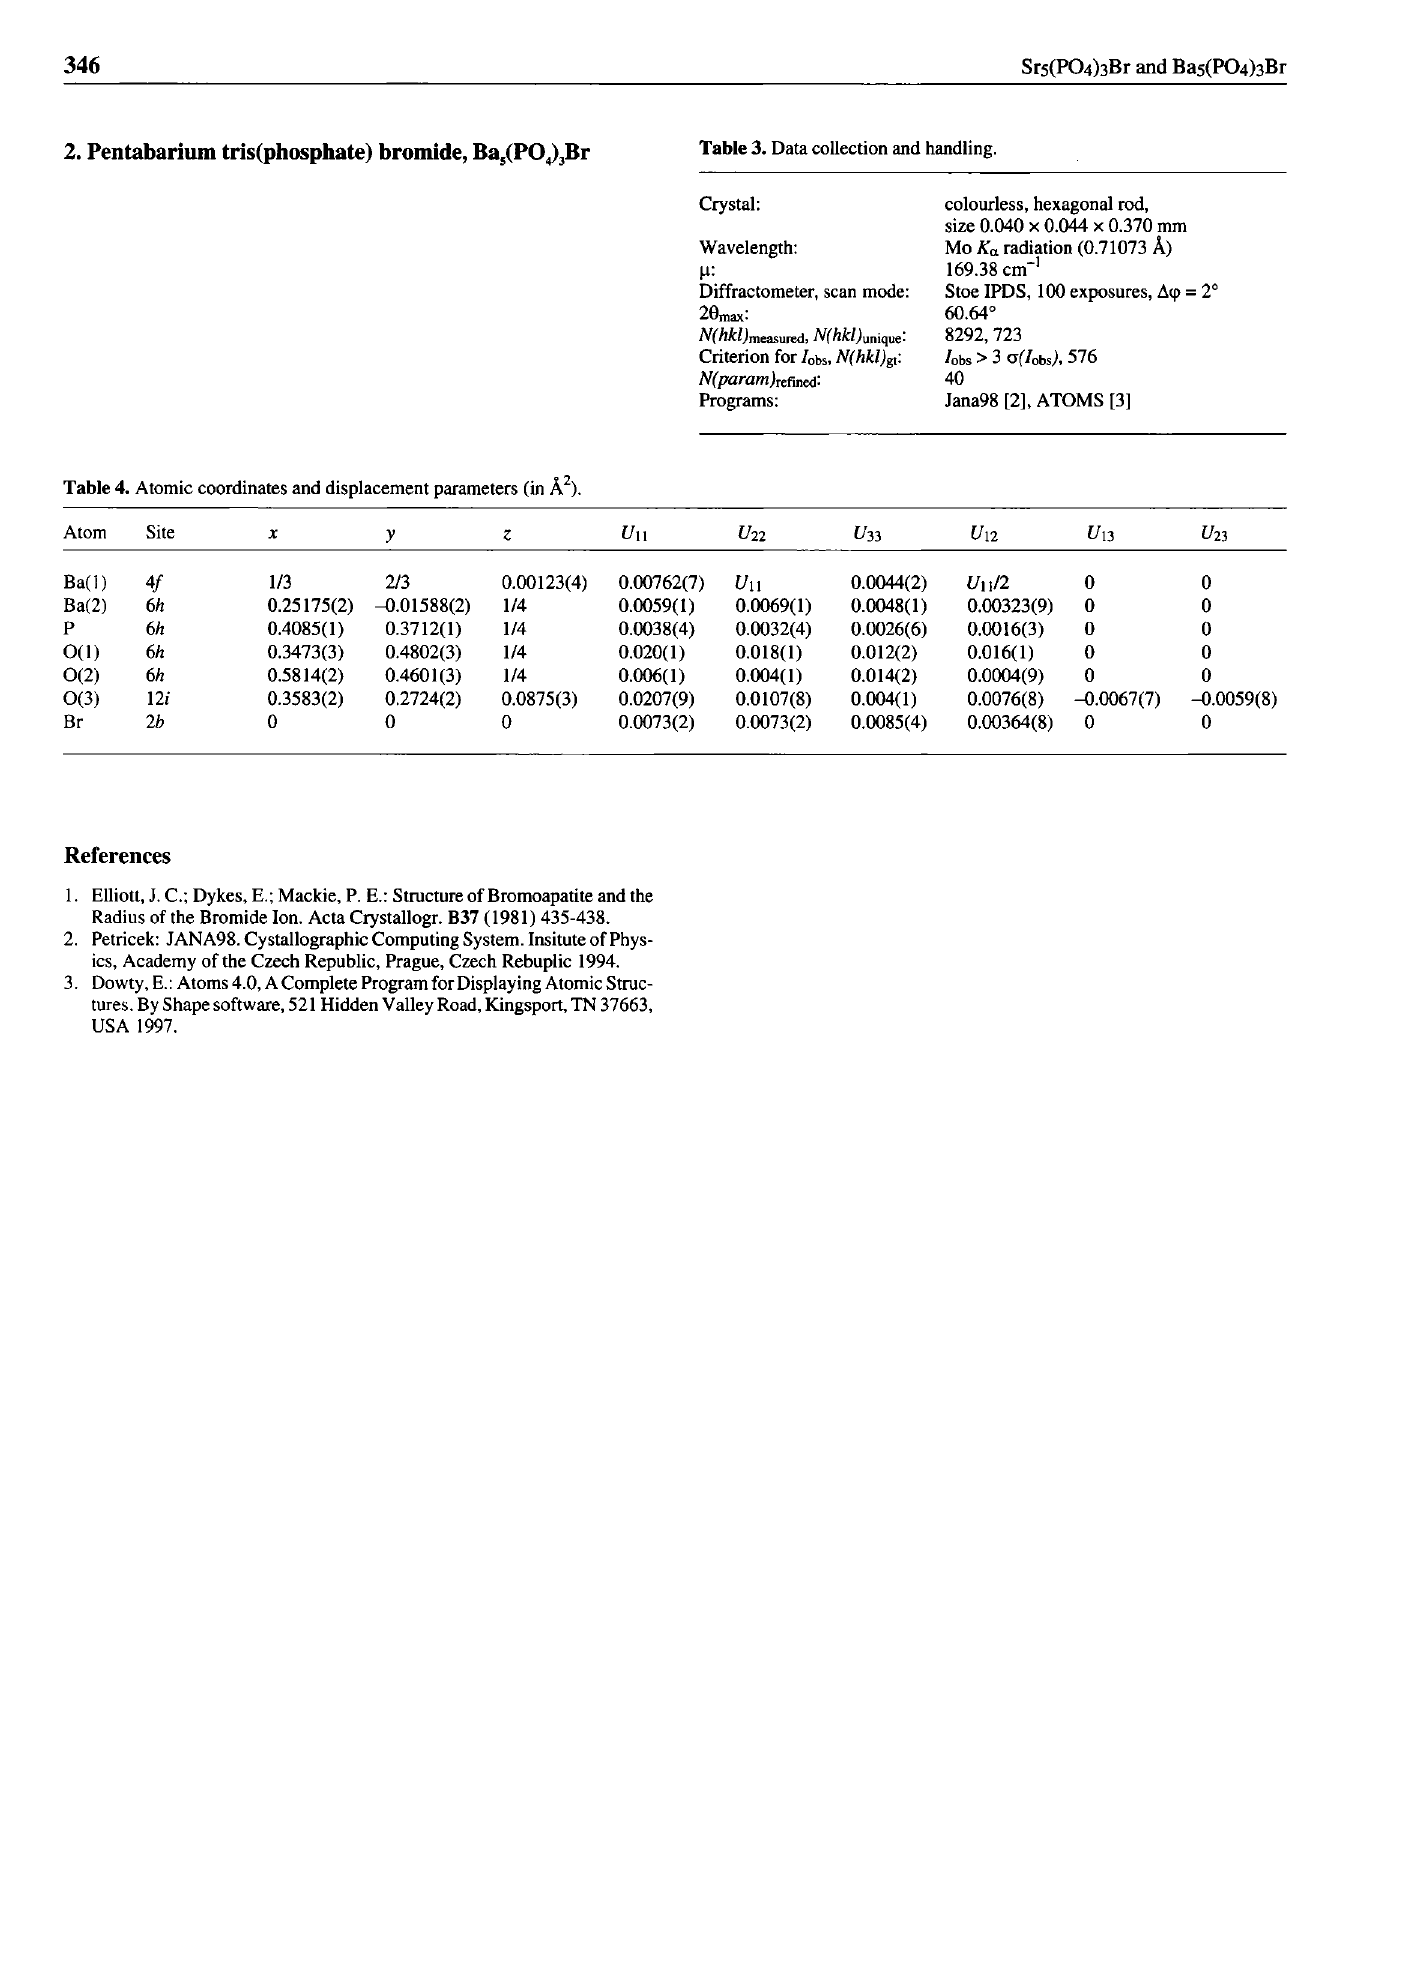
Table 4. Atomic coordinates and displacement parameters (in Ä 2